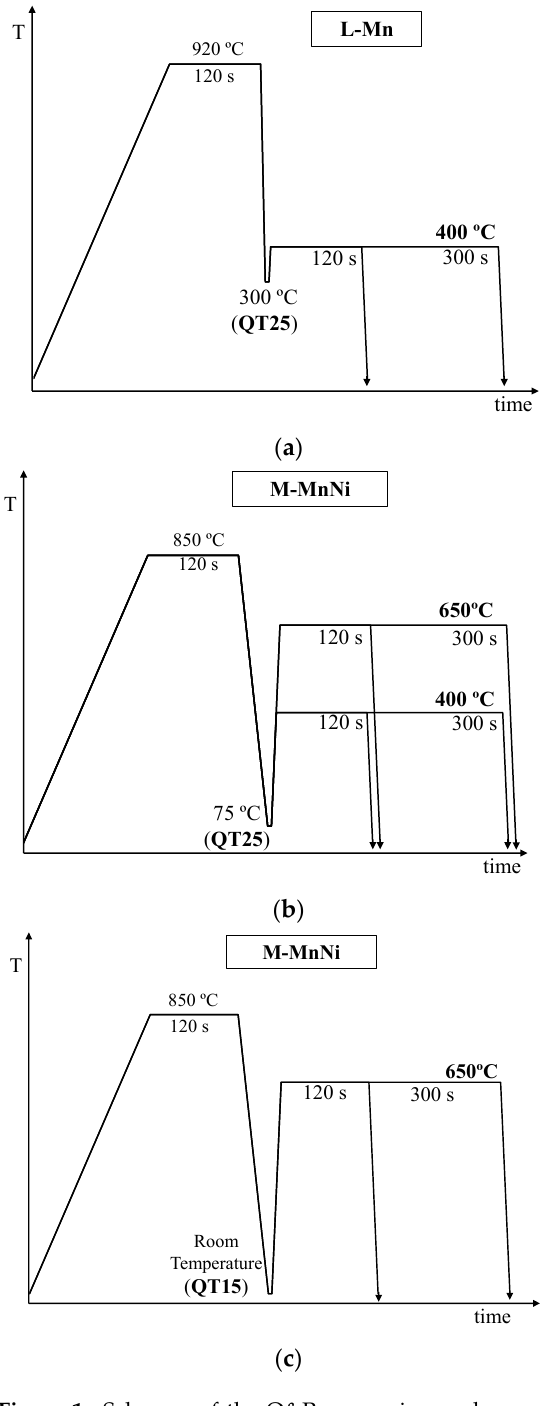
Figure 1. Schemes of the Q&P processing cycles applied in ( a ) L-Mn steel; ( b ) M-MnNi steel— quenching temperature corresponding to 0.25 austenite volume fraction (QT25); and ( c ) M-MnNi steel—quenching temperature corresponding to 0.15 austenite volume fraction